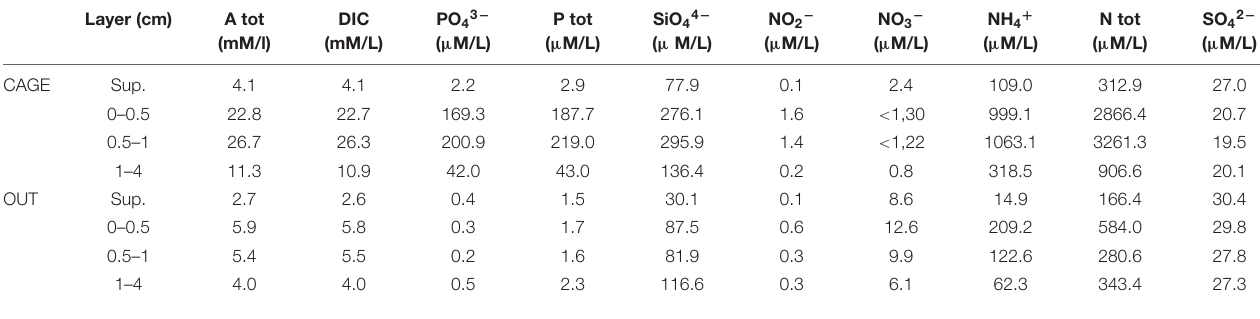
TABLE 3 | Supernatant and pore water analysis of CAGE and OUT